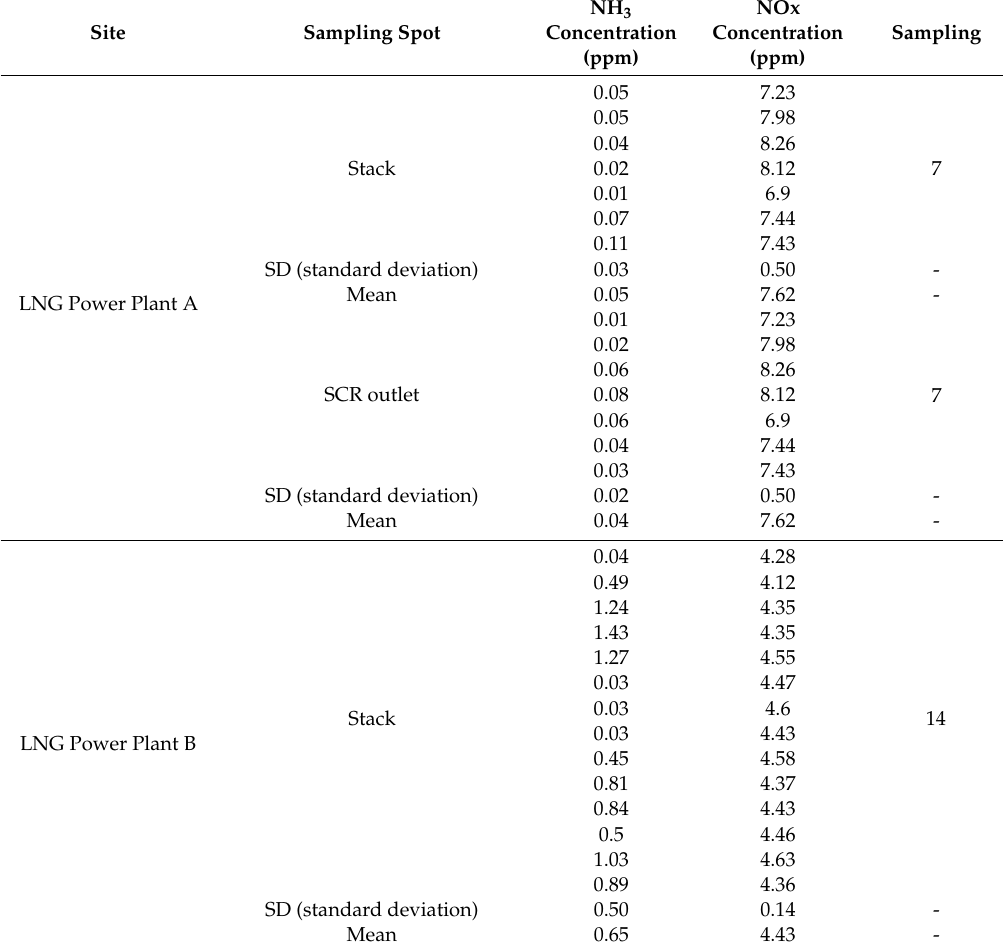
Table 2. NH 3 concentration of the investigated bituminous coal power